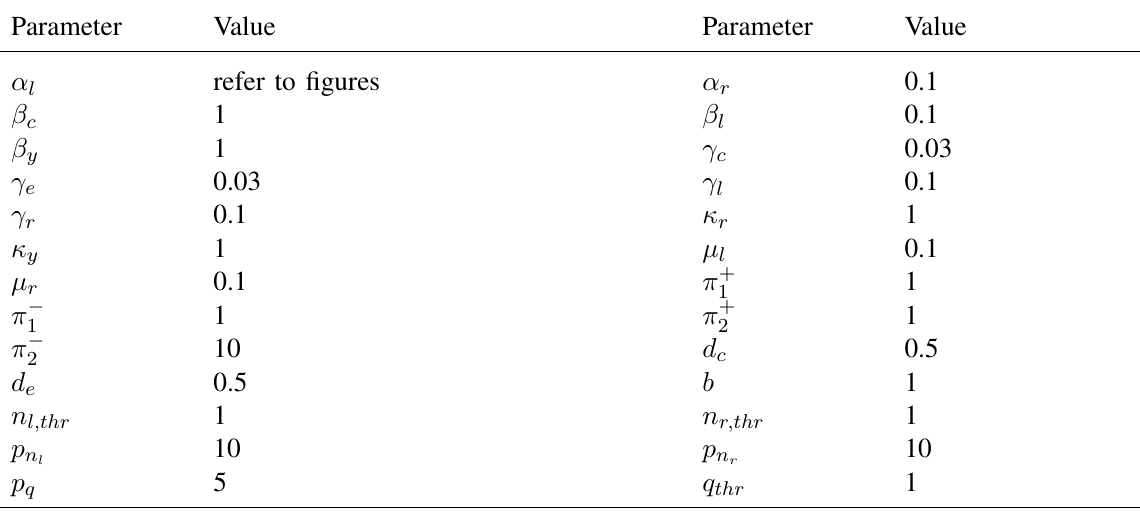
TABLE IV: Values of the dimensionless parameters for the simulations